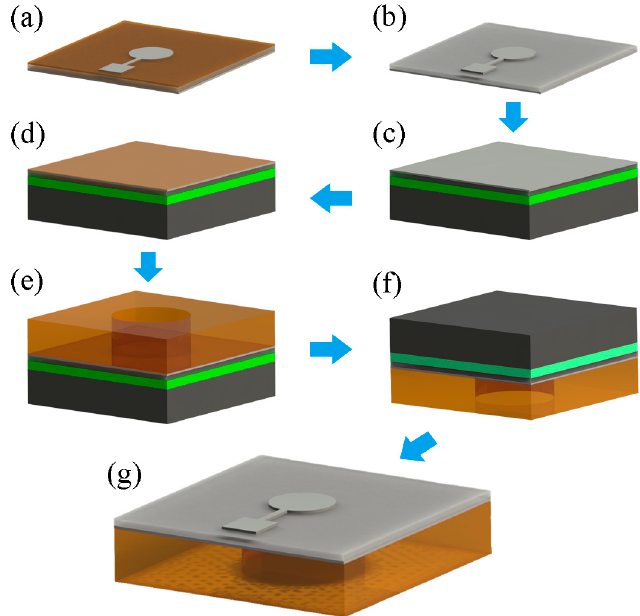
Figure 7. The schematic illustration of the low temperature adhesive bonding fabrication process. ( a ) Pattern top Ag electrode, ( b ) Ag coated PVDF film, ( c ) Ag coated PVDF film pasted on the temporary carrier upside down, ( d ) spin coating a 4 µ m thick PI, ( e ) device assembly, ( f ) solidify the PI and